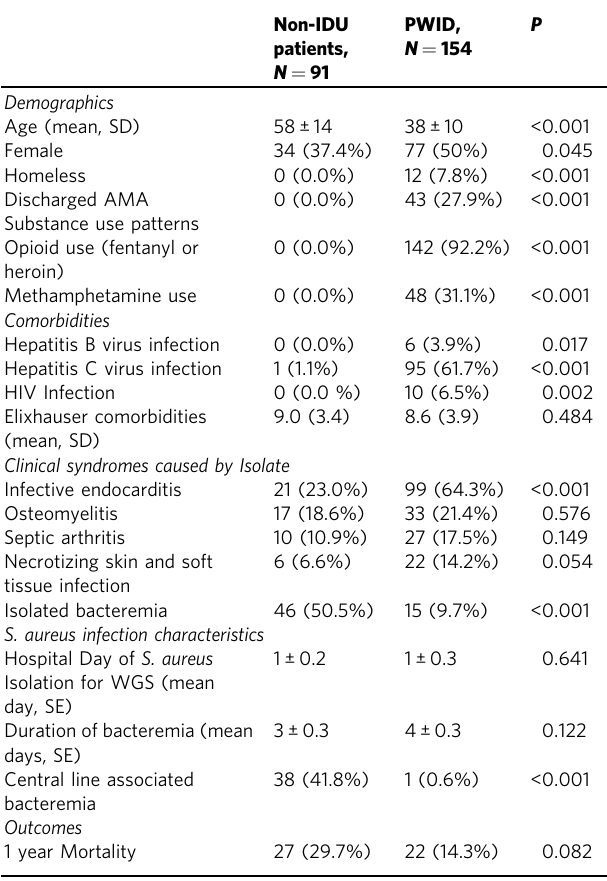
Table 1 Demographics of index isolates included for whole- genome